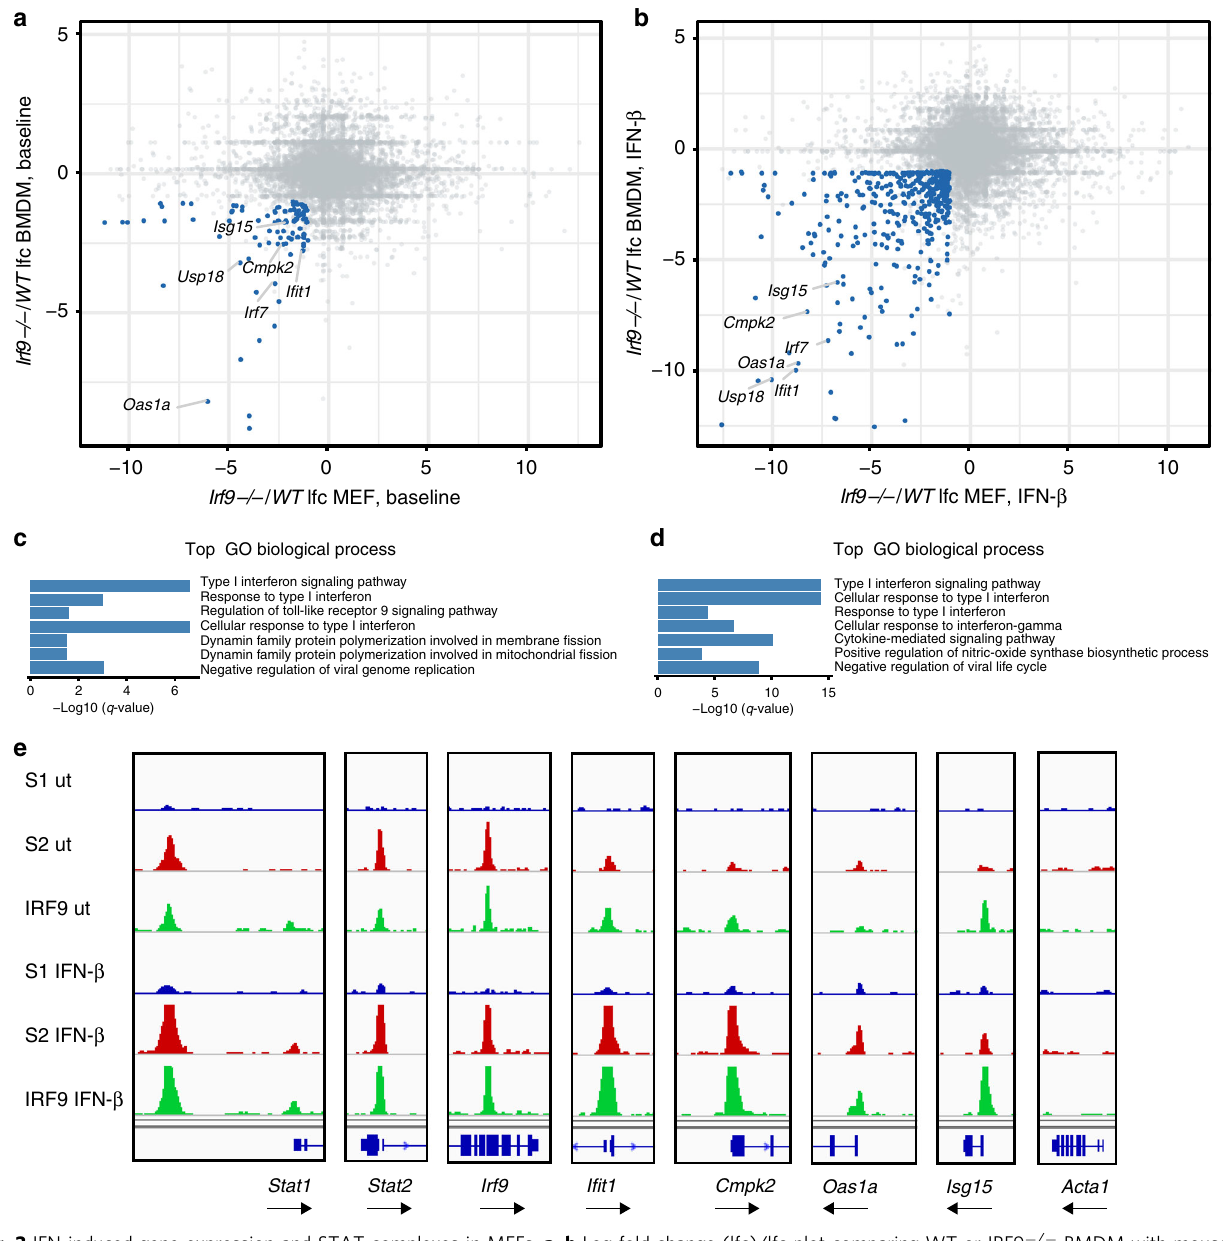
Fig. 3 IFN-induced gene expression and STAT complexes in MEFs. a , b Log-fold change (lfc)/lfc plot comparing WT or IRF9 − / − BMDM with mouse embryonic fi broblast (MEF). mRNA expression ( n = 3) ratios, with a cutoff padj ≤ 0.05 and lfc ≥ 1, ( IRF9 − / − /WT) in resting ( a ) or in IFN- β - treated ( b ) cells is plotted. Genes affected by the loss of IRF9 in both cell types are displayed in blue. c , d GO analysis of the IRF9-dependent genes in untreated ( c ) and IFN- β -treated ( d ) cells as de fi ned in a , b . The top seven pathways are listed for IRF9-dependent genes (in blue). e Representative genome browser tracks for transcription factor binding at ISG and control loci (scale 0 – 60): STAT1 (S1/blue), STAT2 (S2/red), and IRF9 (green). Tracks represent ChIP-seq experiments in untreated and IFN- β -treated